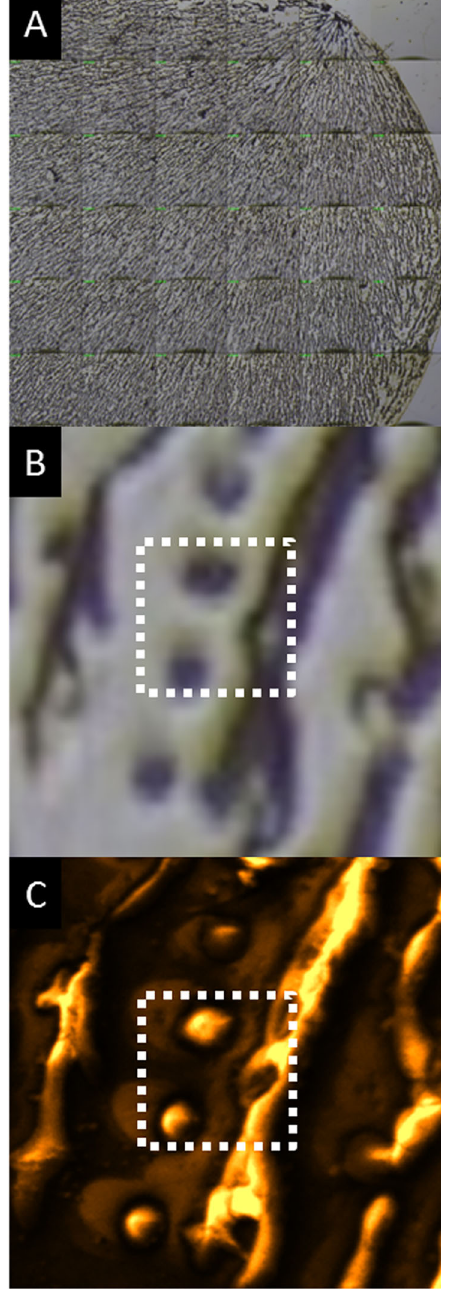
Figure 1. Optical (A, 4500 (cid:1) 4500 μ m and B, 120 (cid:1) 120 μ m field of view) and secondary ion total images (C, 120 (cid:1) 120 μ m field of view) of aggregating D. discoideum cells on a Au/Si substrate. Data are representative of 3 independent